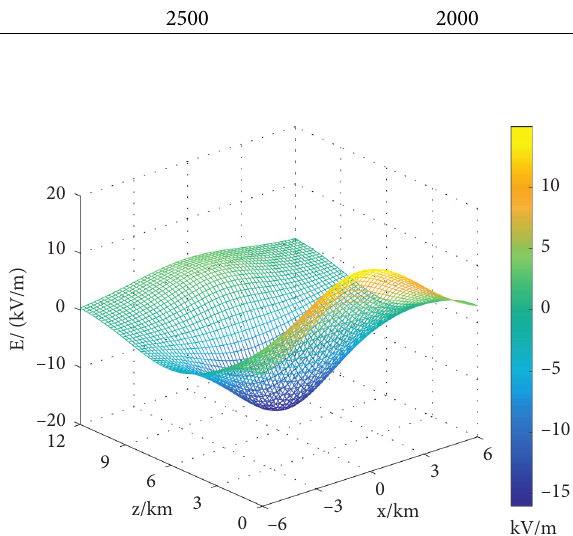
Figure 9: Electric field distribution on the longitudinal section while y � 0.